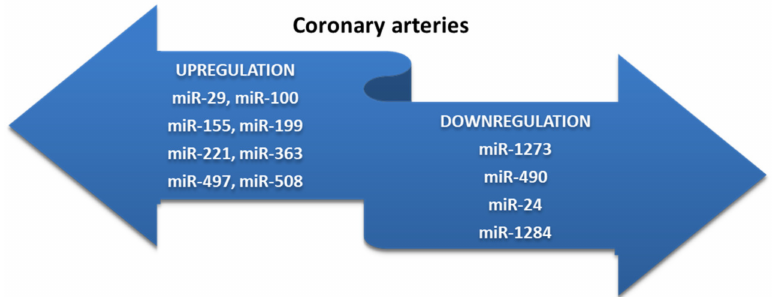
Figure 4. miRNAs as biomarkers in coronary artery disease (adapted from [116]).